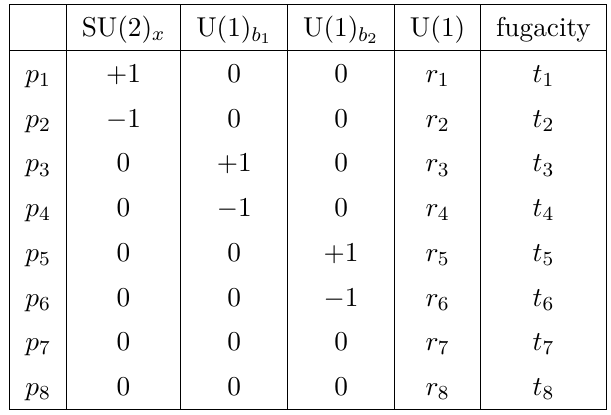
Table 71 . Global symmetry charges on the extremal brick matchings p i of Model